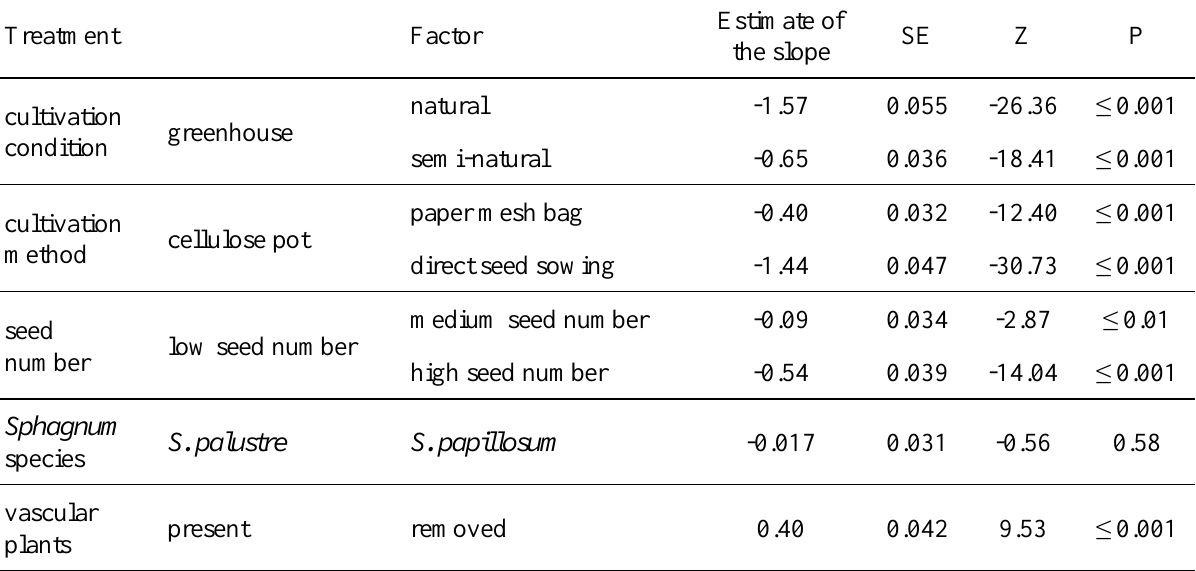
Table A3. Results of the generalised linear modelling of the germination rate (percentage of deployed seeds germinated) for the treatments: cultivation conditions, cultivation method (direct seed sowing = DSS, cellulose pot = CP, paper mesh bag = PMB), number of seeds, Sphagnum species, vascular plants. The seed numbers differed between direct seed sowing (DSS, seed numbers: 10, 50 and 100) and the cellulose pot (CP) and paper mesh bag (PMB, with seed numbers: 3, 6 and 9). Seed numbers were classified as low (3 for CP and PMB and 10 for DSS); medium (6 for CP and PMB and 50 for DSS) and high (9 for CP and PMB and 100 for DSS). Presence/absence of vascular plants was only tested for natural and semi-natural conditions, as in the greenhouse all vascular plants had been removed. SE: standard error; Z : standard scores; P: level of significance. Null deviance: 10,783 on 431 degrees of freedom, Residual deviance: 7,730 on 423 degrees of freedom.